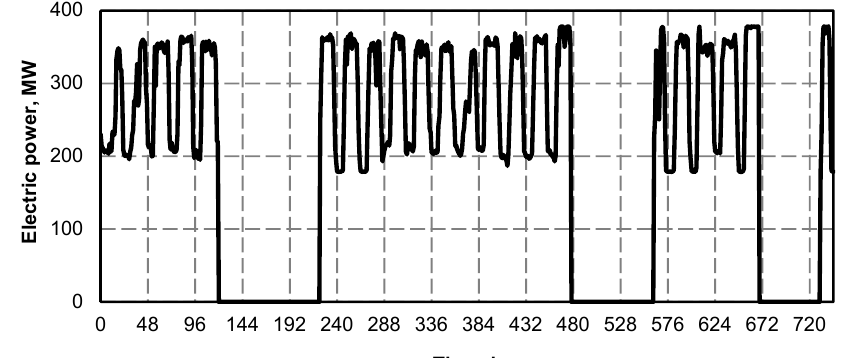
Figure 2. A fragment of all-year, actual hourly average curve of electric power for one of the 370 MW power units in the Opole power plant – January.